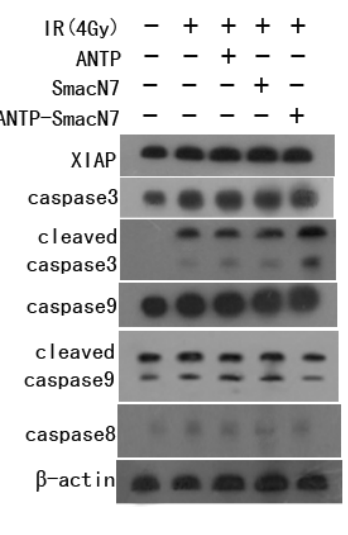
Figure 5. Effects of ANTP-SmacN7 on the tumour cell apoptotic